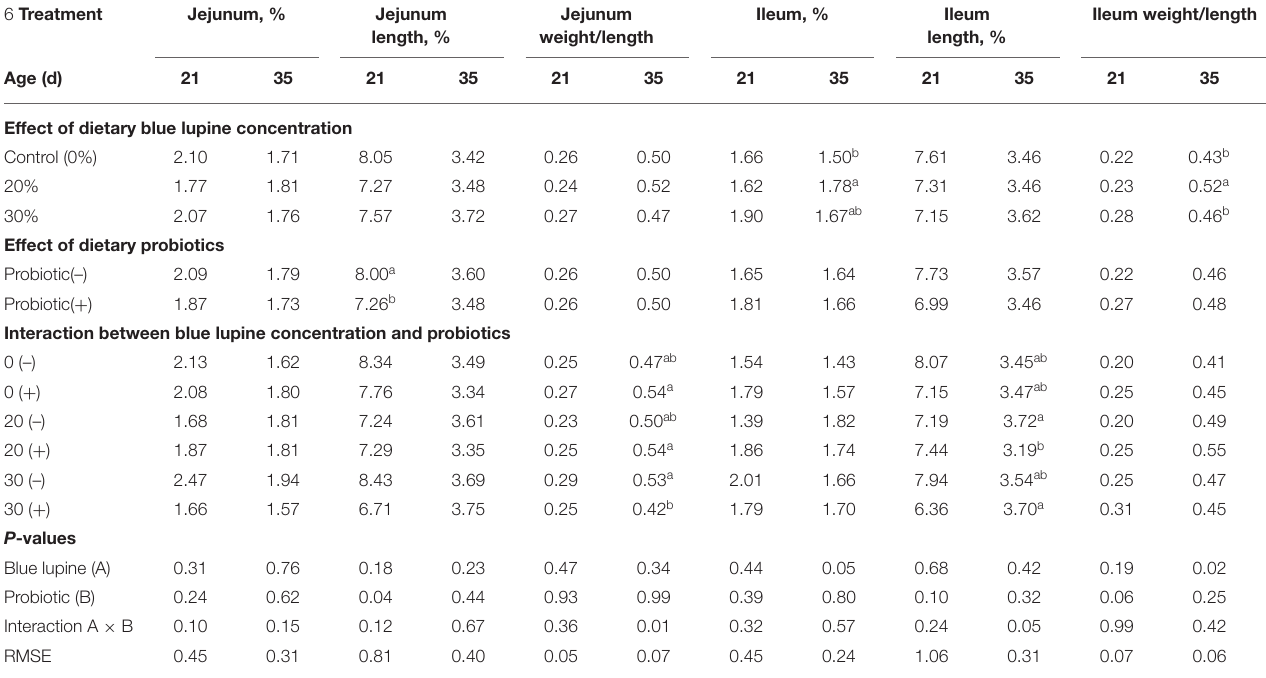
TABLE 9 | Effect of blue lupine and probiotics on jejunum and ileum measurements of broiler chickens at 21 and 35 d of age. 6